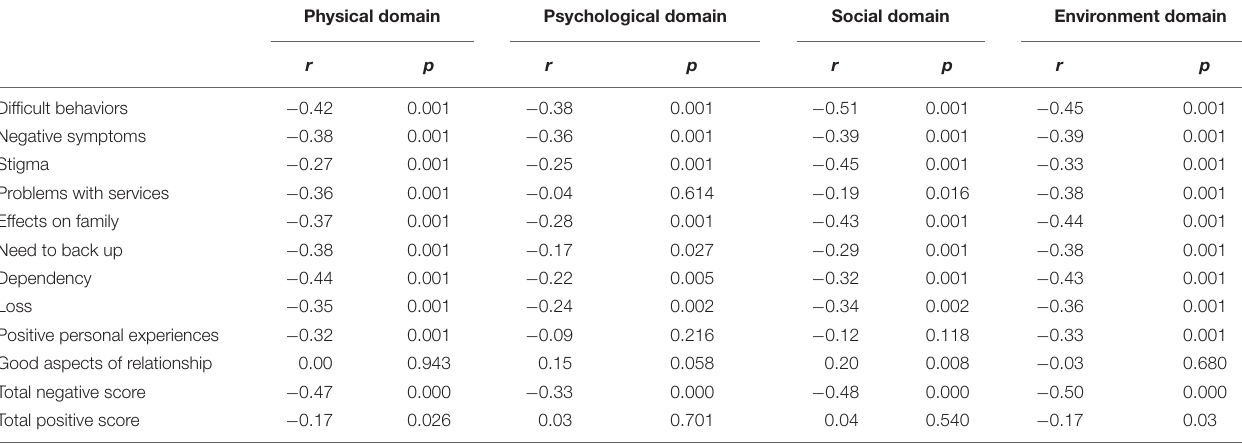
TABLE 5 | The experience of caregiving and the sibling quality of life.